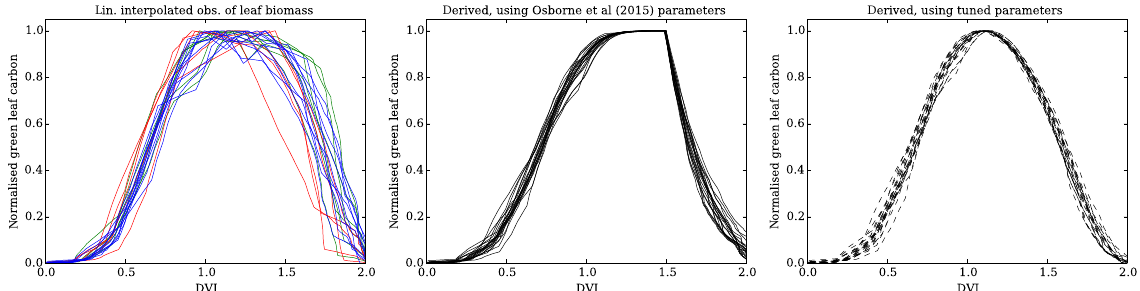
Figure 4. Normalised green leaf biomass against DVI. Blue, green and red lines (left plot) are derived from US-Ne1, US-Ne2 and US-Ne3 observations respectively. Solid black lines (centre plot) are generated using model parameters from Osborne et al. (2015) and dashed black lines (right plot) are generated using the new, tuned